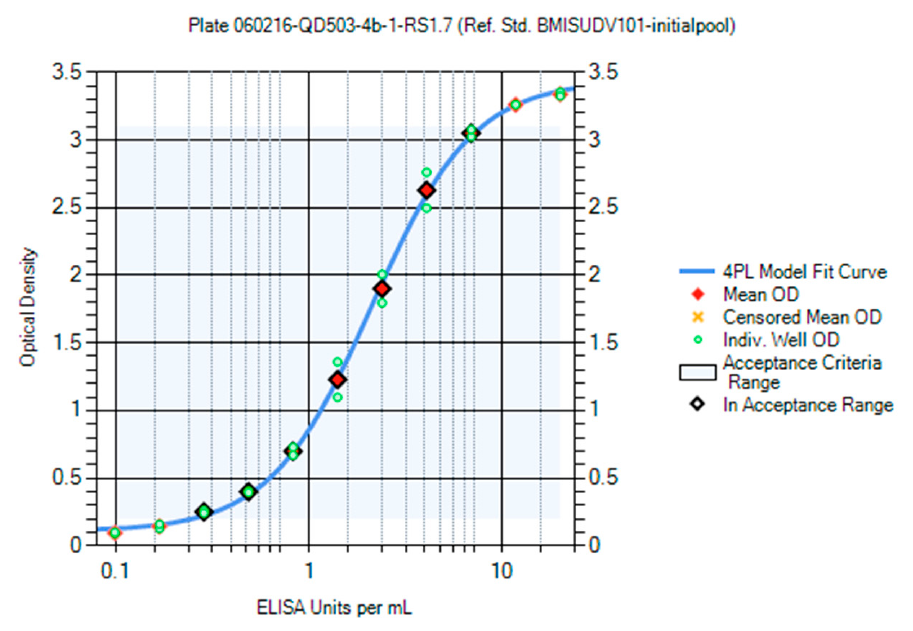
Figure 8. Optimization of BMISUDV101 Reference Standard Dilution Scheme. BMISUDV101 was tested at a 1:50 starting dilution and 1:1.7 dilution scheme.